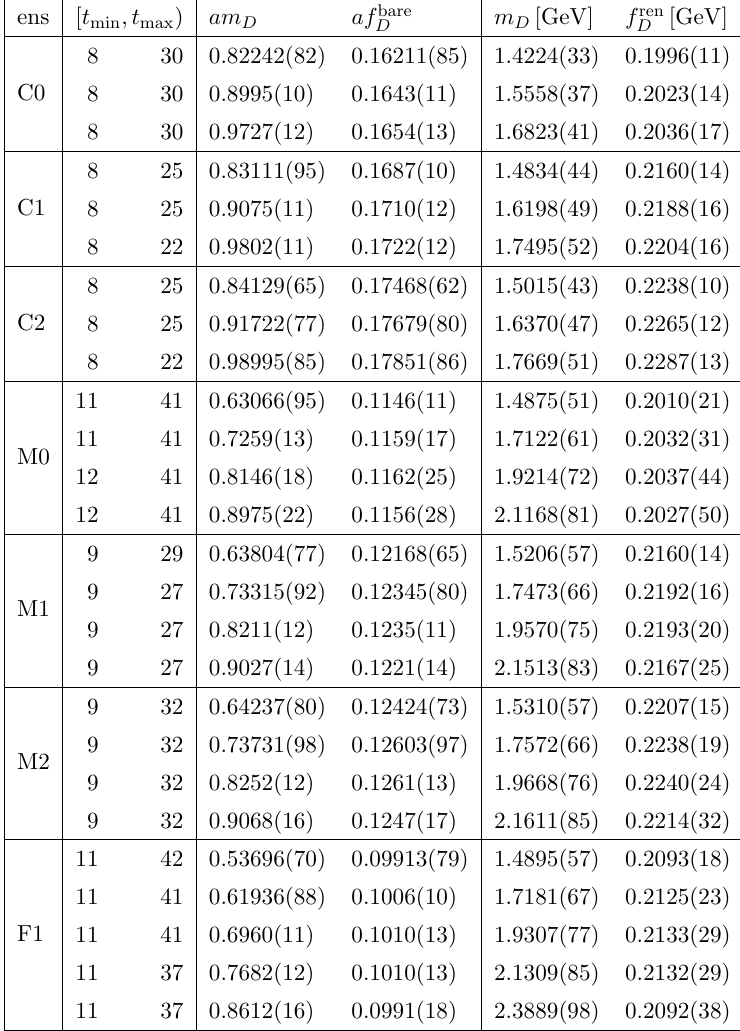
Table 11 . Fit results for the masses and decay constants of the D meson on all ensembles. The second set of columns is renormalised where the renormalisation constants are obtained from the light-light conserved current as described in the text.